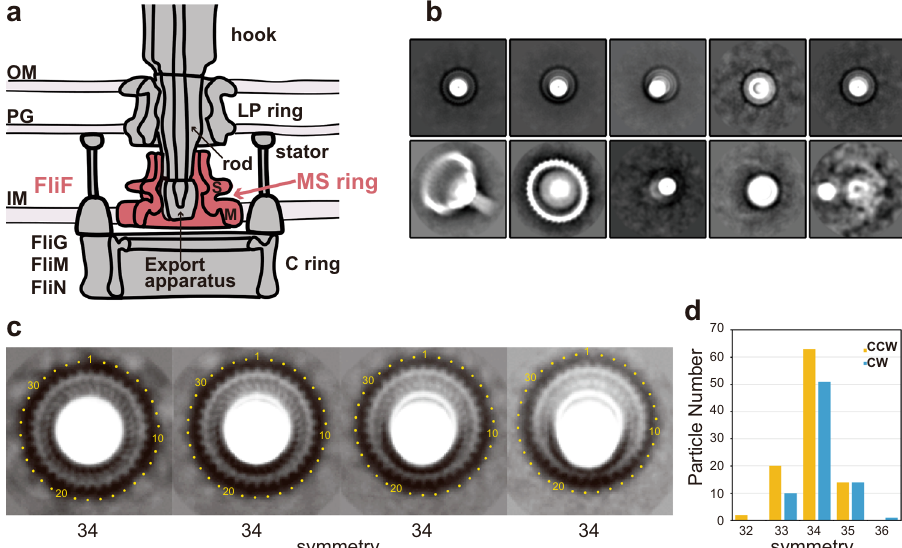
Fig. 1 Schematic diagram and cryoEM image analysis of the fl agellar basal body. a Schematic diagram of the fl agellar basal body. IM: inner membrane, PG: peptidoglycan layer, OM: outer membrane. b Representative 2D class average images in the fi rst round. The upper row images show end-on views of the MS ring with rod called rivet (see Supplementary Fig. 1a) except for the second from the right; in the lower row, the two panels on the left show the rivet with the C ring attached. c Images showing the rotational symmetry of the S ring are extracted from the second round of 2D class average of the rivet class images and magni fi ed. The rotational symmetries obtained by image analysis as shown in Supplementary Fig. 1 are indicated below, presenting direct evidence for the 34-fold symmetry of the native MS ring. d The rotational symmetry distributions of the C ring: CCW in yellow is the wild-type motor in the CCW state (98 particles in total); and CW in blue is the CW-locked motor by FliG Δ PAA mutation (75 particles in